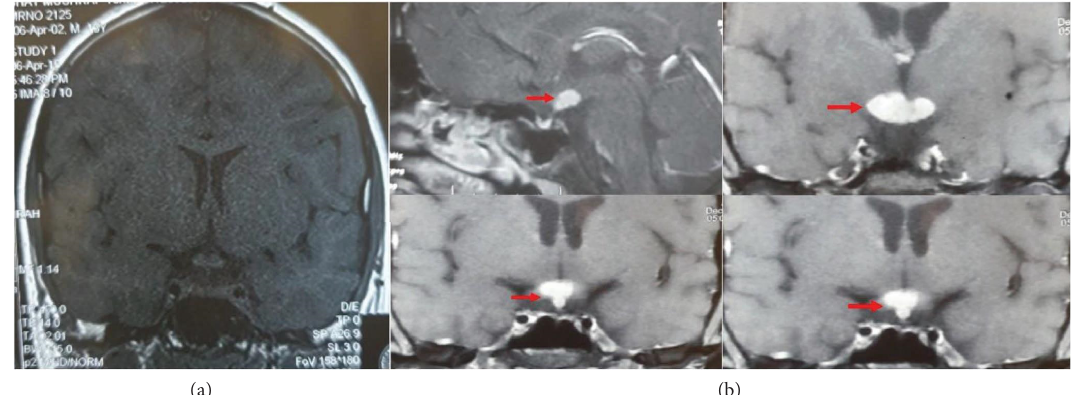
Figure 2: MRI sella showing (a) enhancing lesion involving hypothalamus and infundibular stalk 14 × 8mm, isointense on T1W and hypointense on T2W at 3 years after 1 st presentation, and (b) increase in size of enhancing mass lesion in the upper part of stalk 20 × 17 × 15mm, 2 years after